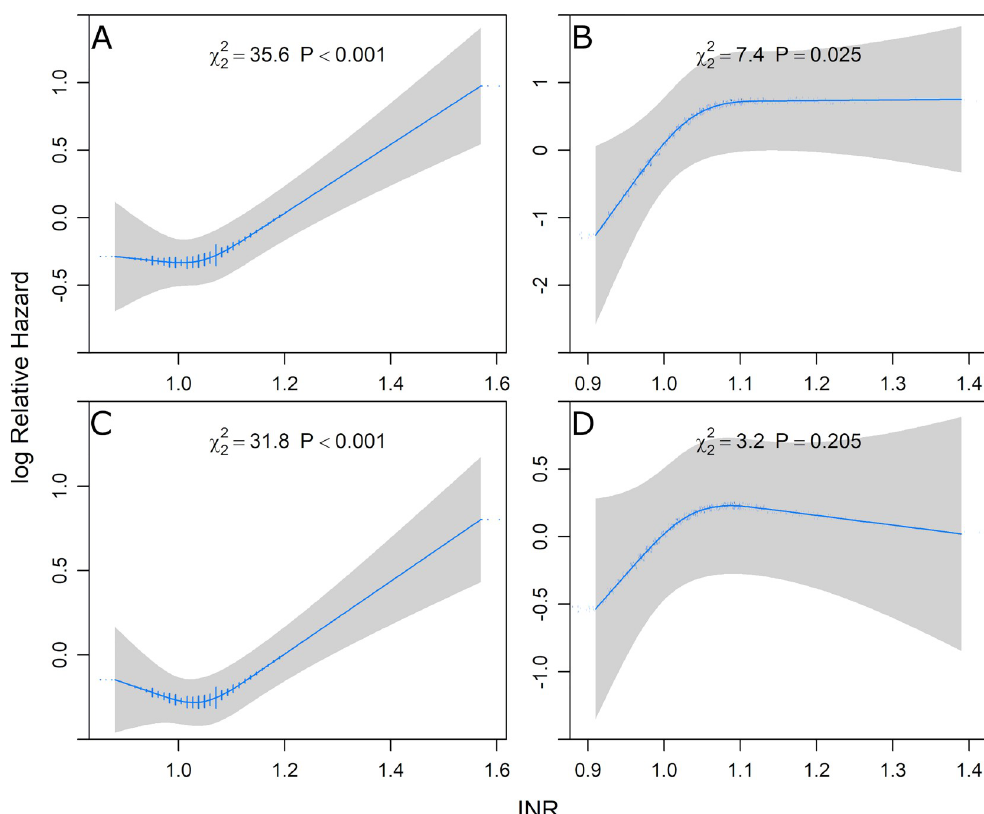
Fig 2. Relationship between INR and mortality. Cox proportional hazards regression including the INR modelled as restricted cubic splines with three knots with adjustment for age, gender, BMI, LDL-C, HDL-C, diabetes mellitus, hypertension, smoking status and the use of antiplatelet and lipid lowering drugs has been used to analyze the association of the INR with cardiovascular mortality (A+B) and all-cause mortality (C+D), separately for CAD positive and CAD negative patients. The log relative hazard is plotted against the INR